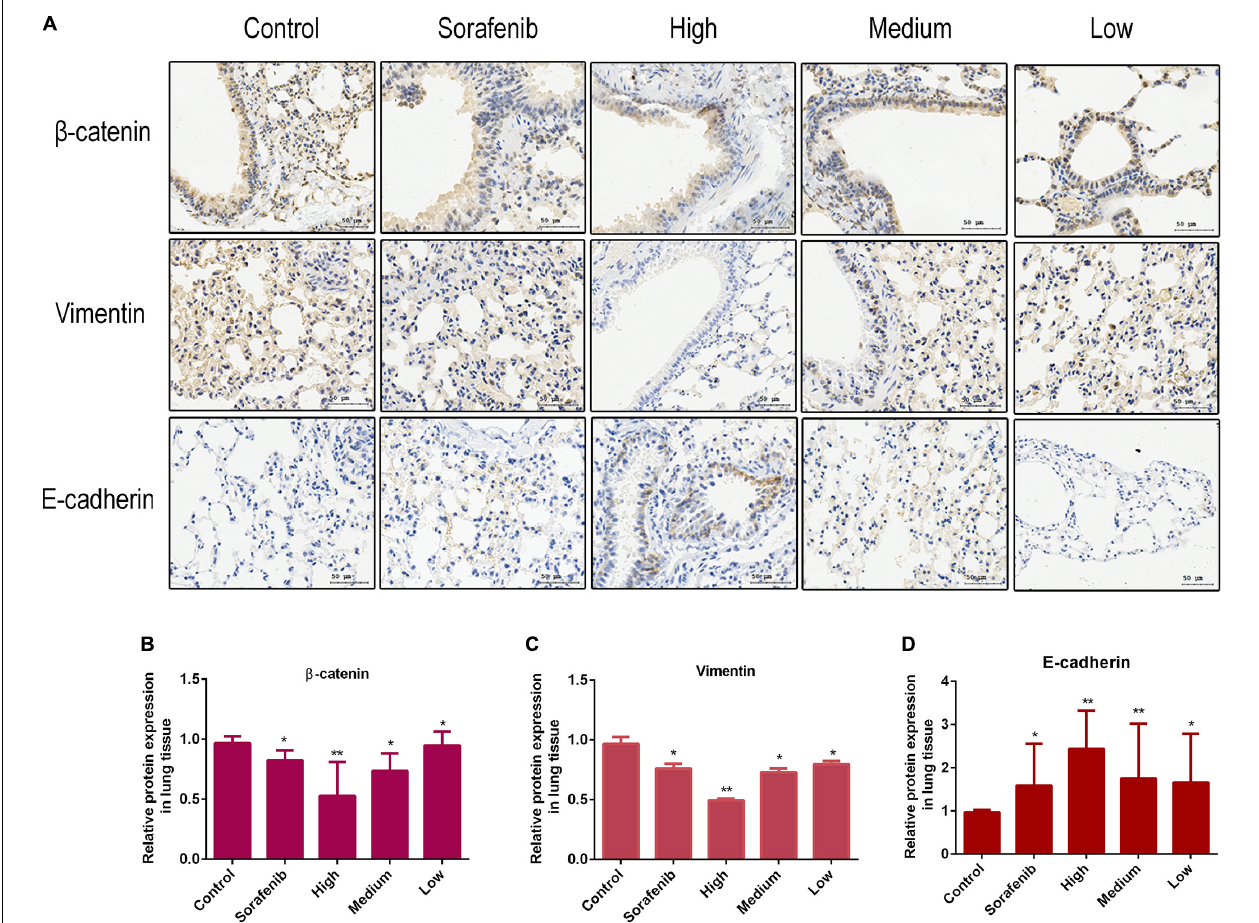
FIGURE 6 | AAEO treatment suppresses Wnt/ β -catenin signaling and EMT in nude mice bearing tumors. (A) The expression of β -catenin, E-cadherin, and vimentin examined by immunohistochemistry. (B–D) Fold changes in β -catenin and EMT related protein expression in lung metastasis tissue. Data are expressed as the mean ± SD of three independent experiments. *p < 0.05 and **p < 0.01 vs. the control